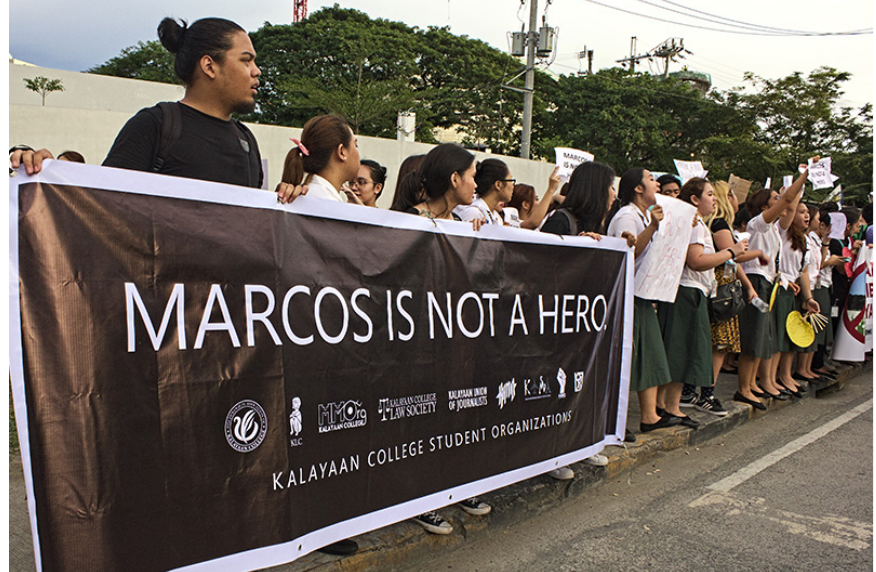
Figure 2. Monolingual protest sign (English). College students from a university in Manila, along with student organizations, make their feelings known via a large vinyl banner announcing “Marcos is not a hero”. (“Kalayaan” in ‘Kalayaan College Student Organizations’ is Tagalog for ‘freedom’.) (Photo by Terzeus S. Dominguez for Philstar.com). Table 1. Languages used in protest